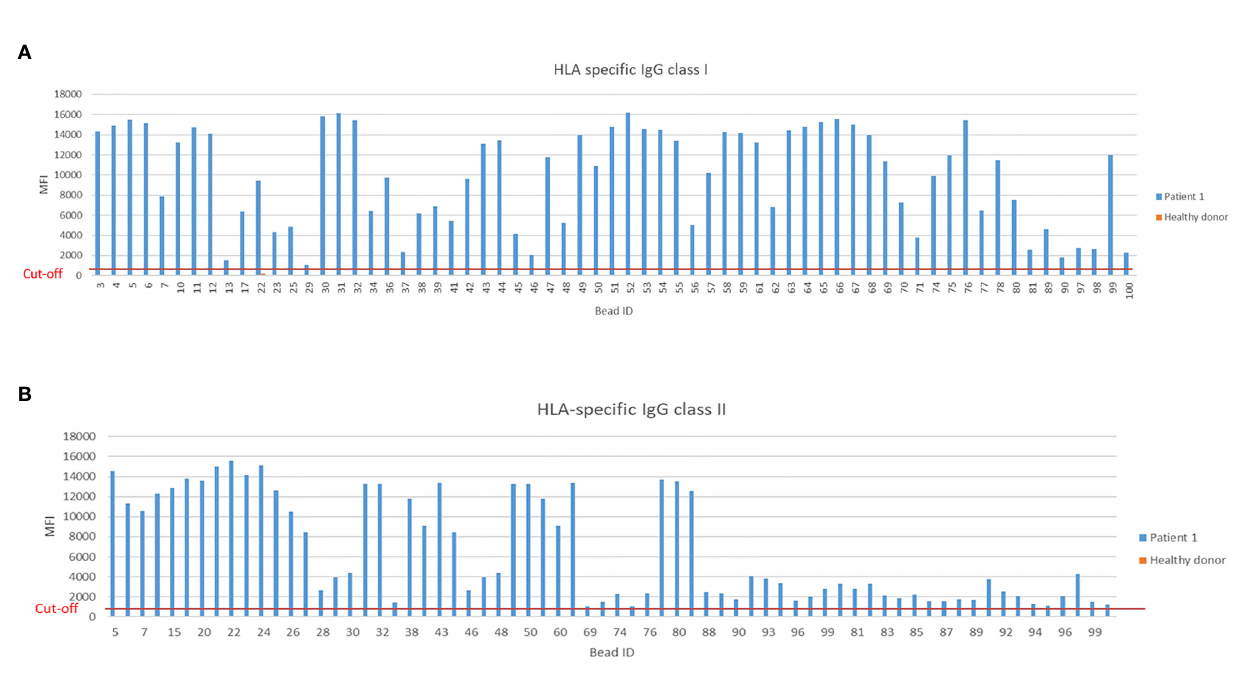
FIGURE 9 | Measurement of HLA-speci fi c IgG HLA class I and II in a sensitized kidney transplant recipient. (A) Positive MFI signals measured by Luminex bead based assay for IgG speci fi c HLA class I and (B) HLA class II from a highly sensitized kidney transplant patient. Threshold for HLA-speci fi c IgG reactivities was set at MFI>1000.